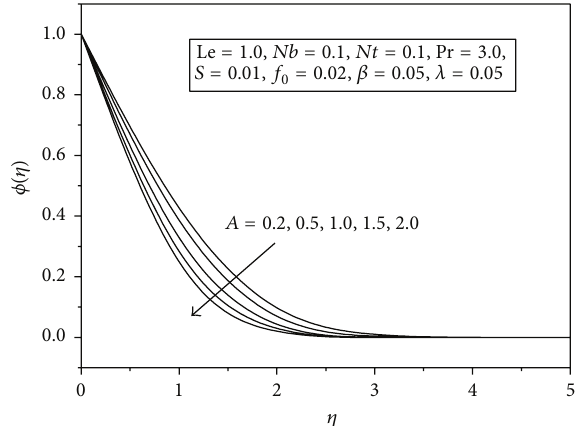
Figure 4: Concentration profile for different values of 𝐴